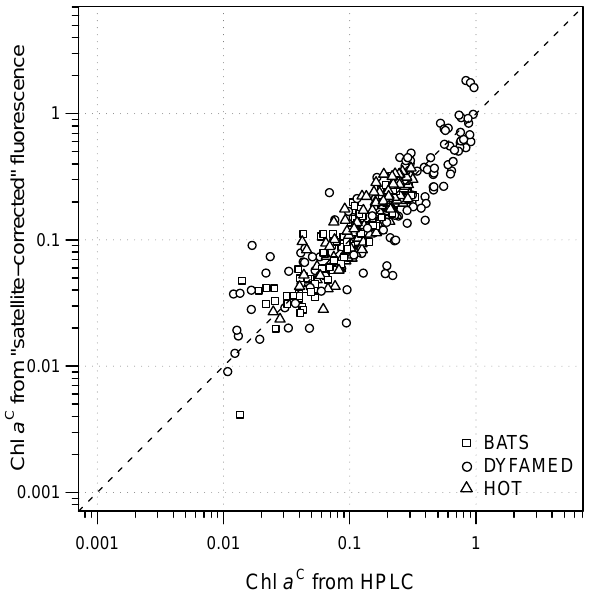
Fig. 5. Scatter plot of Chl a C derived from “satellite-corrected” flu- orescence profiles as a function of Chl a C measured with HPLC, after having applied a monthly average filter. Chl a C is expressed in mgm − 3